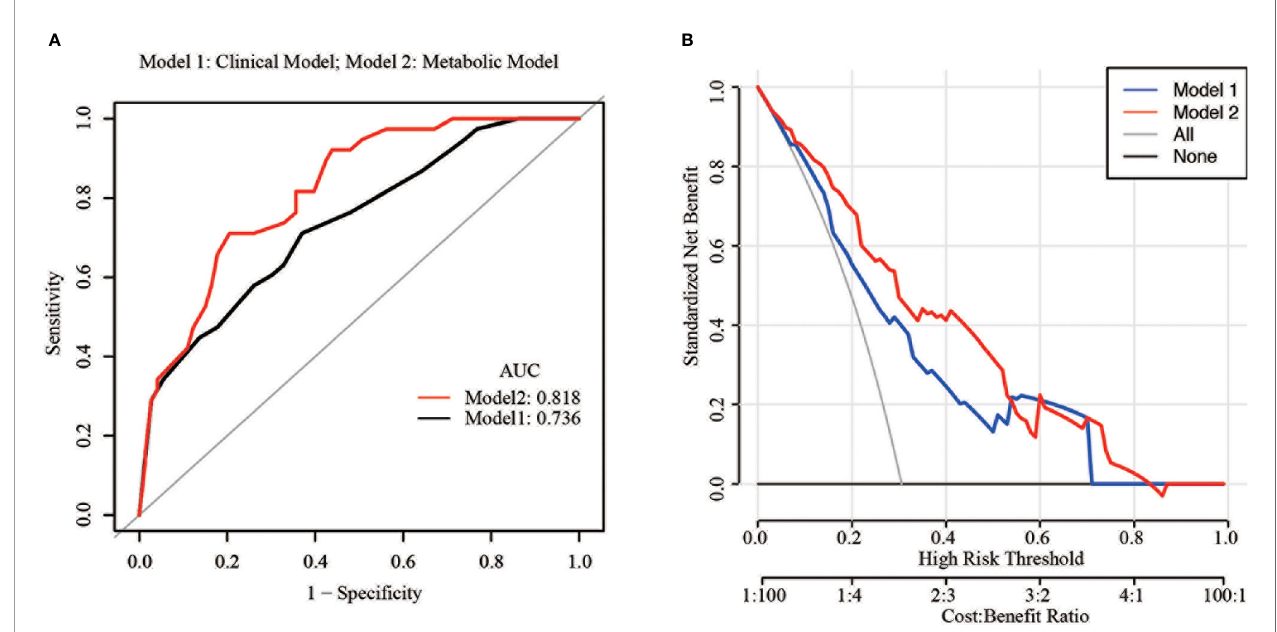
FIGURE 2 | Predictive accuracy of different models. (A) Area under the receiver operating characteristic curves (AUCs) of models 1 and 2 for the prediction of recurrence in fertility-sparing treatment patients; (B) Decision curve analysis of the